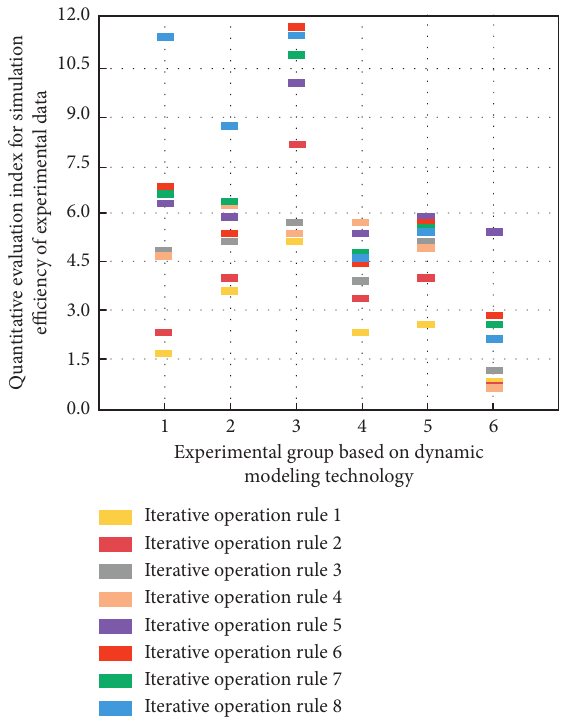
Figure 9: Quantitative evaluation and analysis of simulation ef- ficiency of experimental